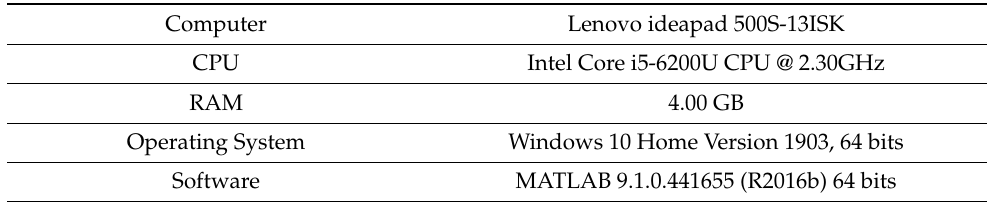
Table 2. The computer system and software used in the two